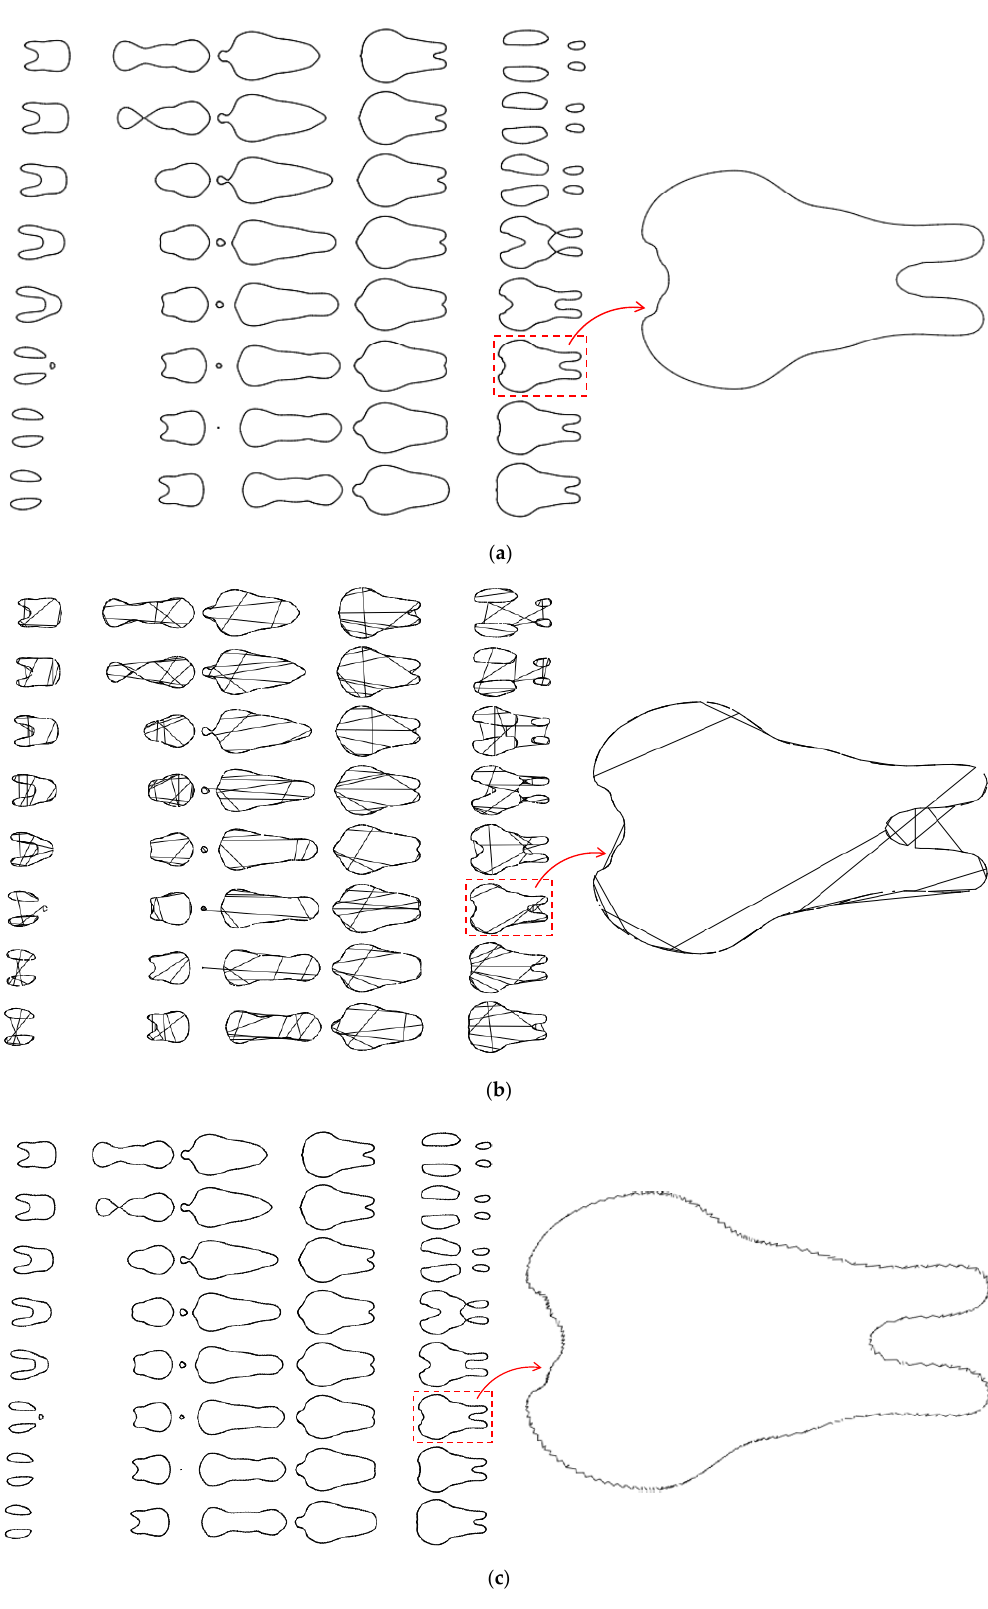
Figure 10. Experimental results 2D slices of Bunny model, ( a ) Original 2D slices, ( b ) Encrypted 2D slices in DCT domain, and ( c ) Encrypted 2D slices in spatial domain.